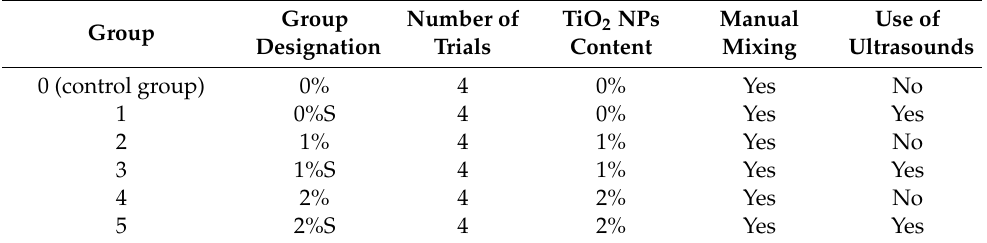
Table 2. Characteristics of groups during the initial polymerisation time